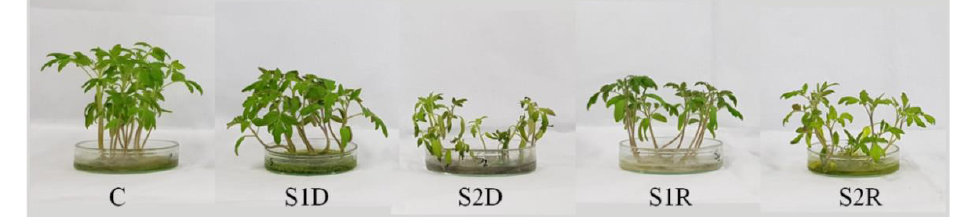
Figure 3. Visual di ff erences of tomato plants under salinity (150 and 250 mM NaCl) and after a 48 h recovery period. (C, control; S1D, 150 mM NaCl; S2D, 250 mM NaCl; S1R, recovered 150 mM NaCl; and S2R, recovered 250 mM NaCl).